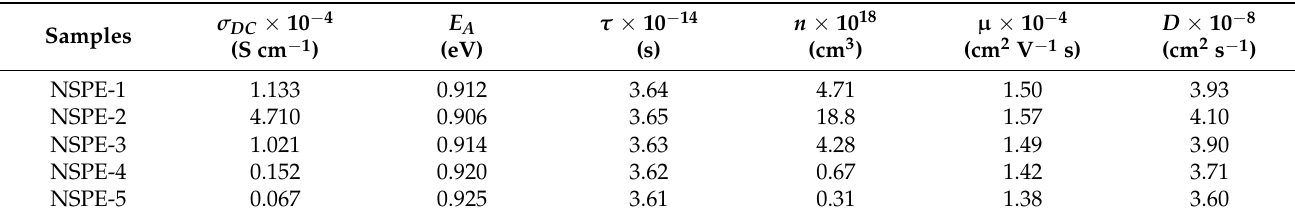
Table 1. Transport parameters for PVA/NH 4 NO 3 /ZnO nanocomposite solid polymer electrolytes (NSPEs) samples at room temperature.